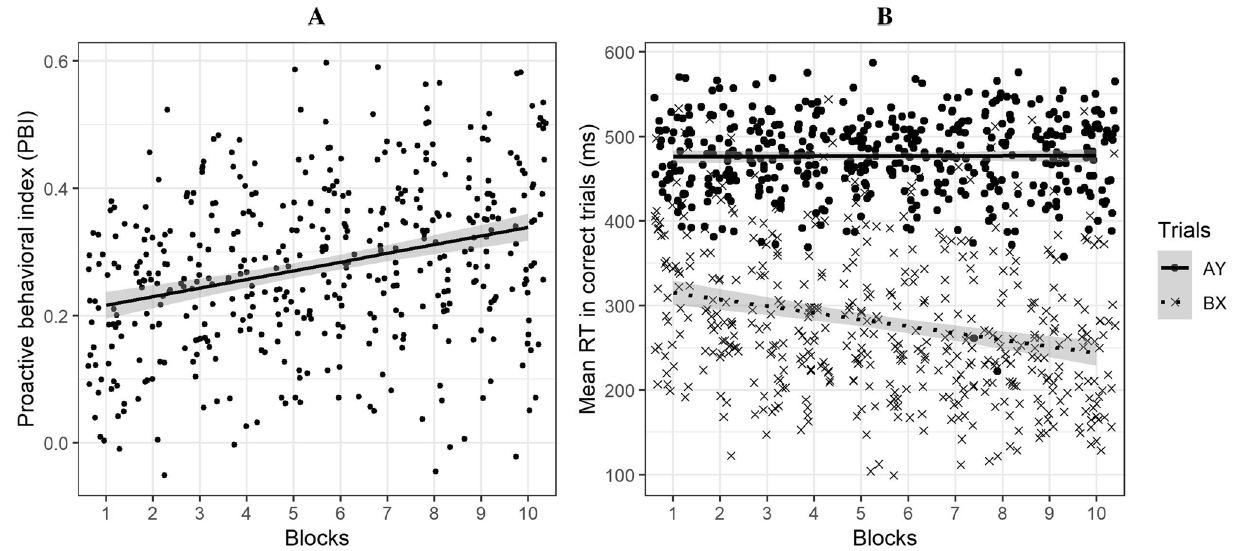
Figure 3. Evolution of the proactive behavioral index ( A ) and the RTs in correct AY and BX trials ( B ) across blocks. ( A ) The proactive behavioral index (PBI), calculated as (AY − BX)/(AY + BX), increased across blocks. ( B ) The BX trials RTs progressively decreased whereas the AY trials RTs remained stable across blocks. The increase in the PBI is therefore due to a decrease in the involvement of reactive control processes. The grey areas represent the 0.95 confidence interval bands.